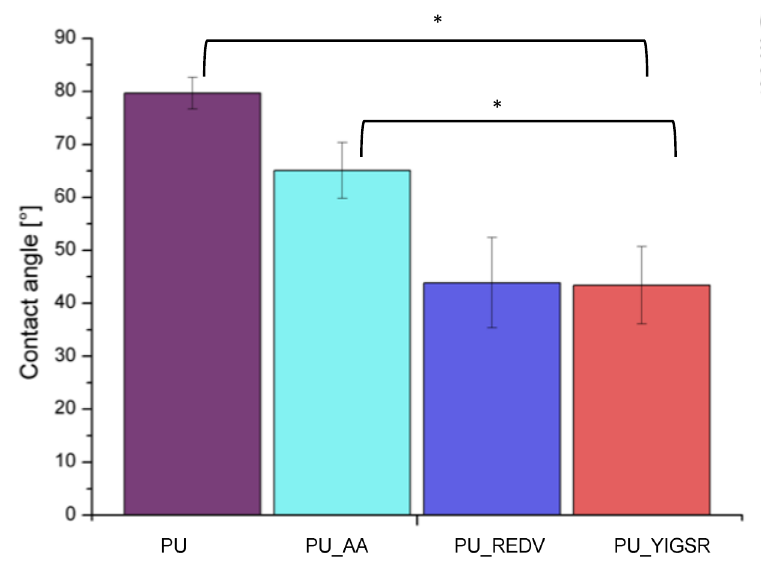
Figure 5. The wettability results (MV ± SD, n = 4) *: p < 0.05.